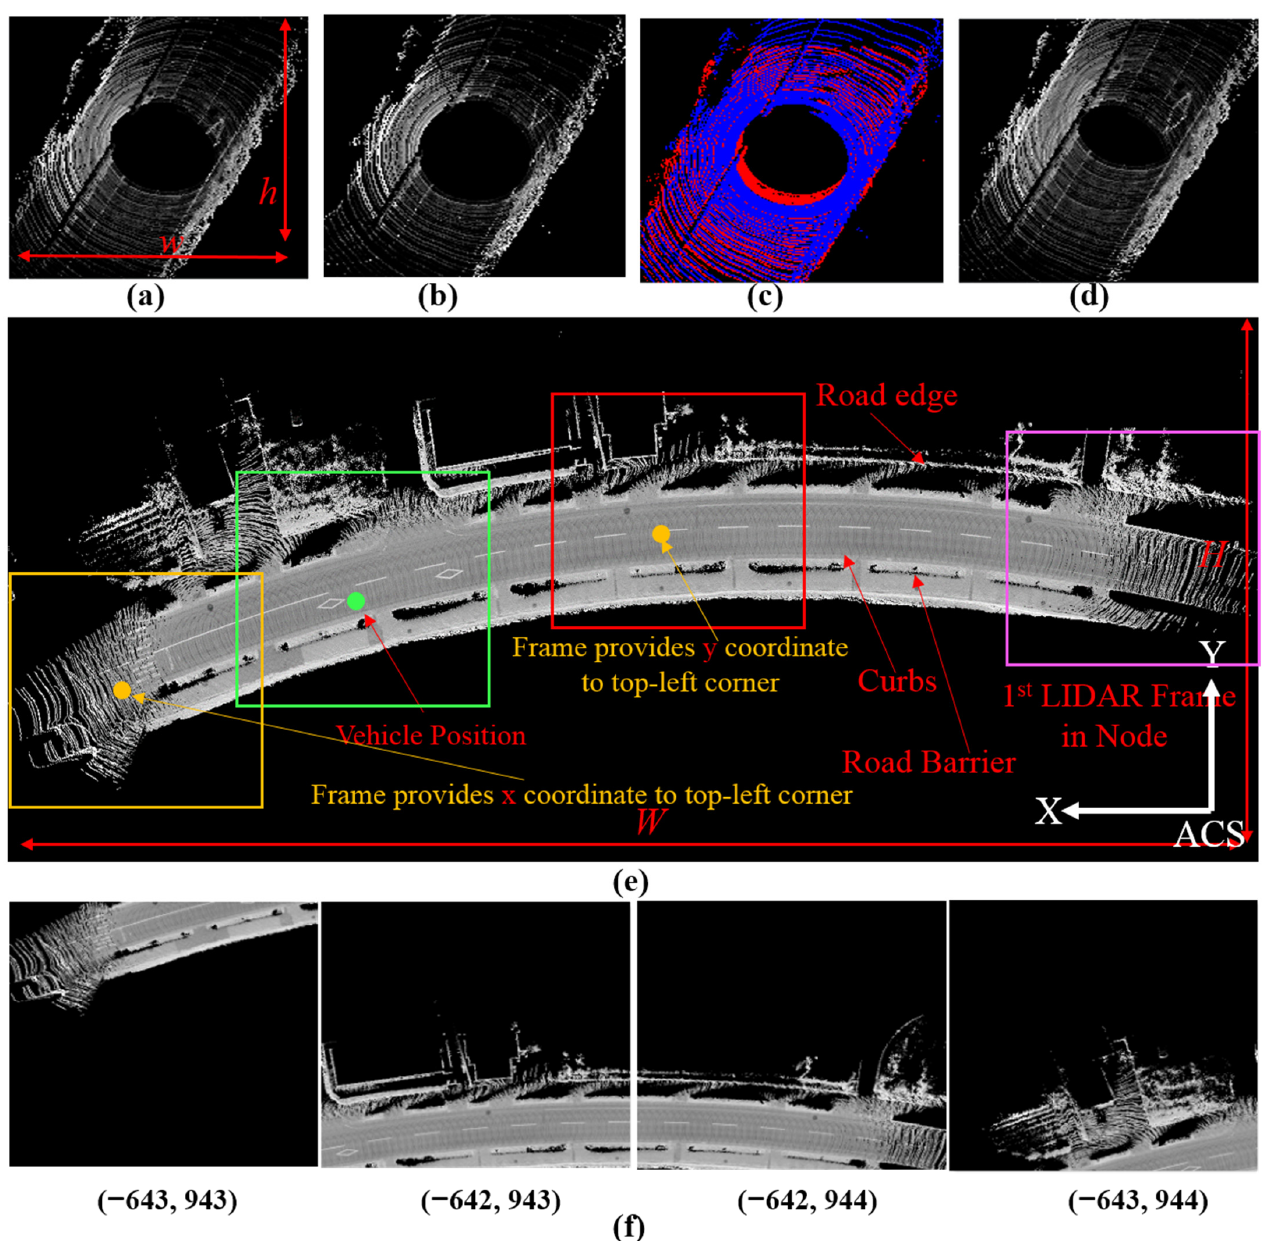
Figure 1. Mapping strategy in node domain. ( a ) 1st LIDAR frame. ( b ) 2nd frame. ( c ) Common pixels. ( d ) Accumulated image. ( e ) Node intensity image. ( f ) Four sub-images in node ( e ) with global IDs ( x , y ).